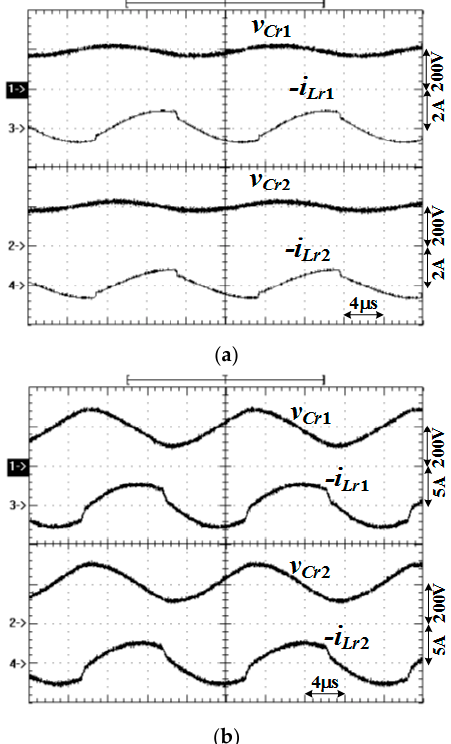
Figure 7. Measured primary-side waveforms of LLC resonant converters under ( a ) 20% load ( b ) 100% load.